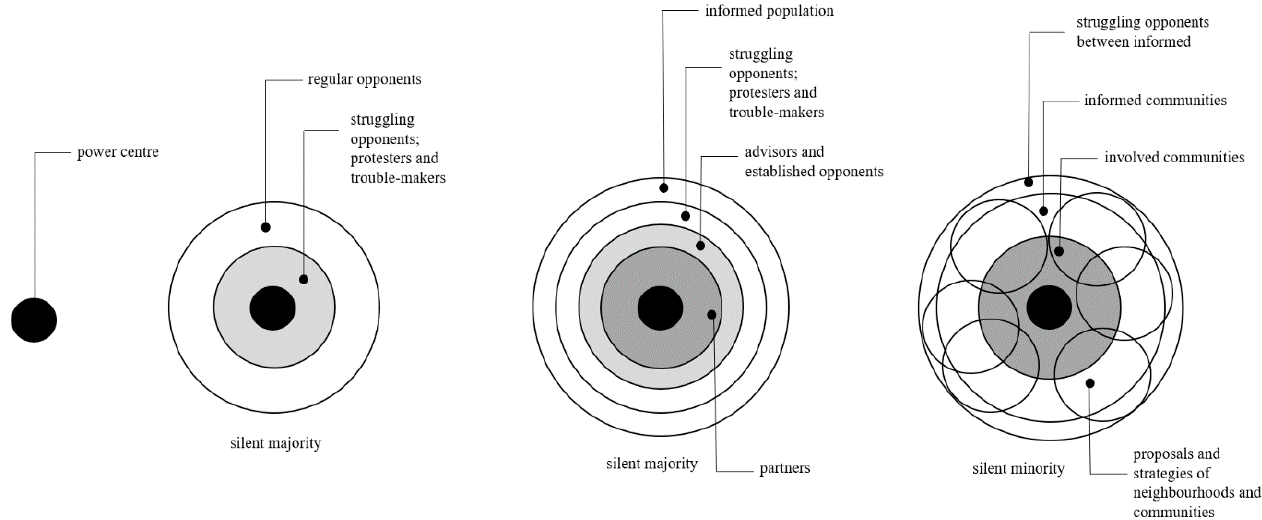
Figure 1. Changes in the multidimensional model of participation from a totalitarian to a knowledge-based society.